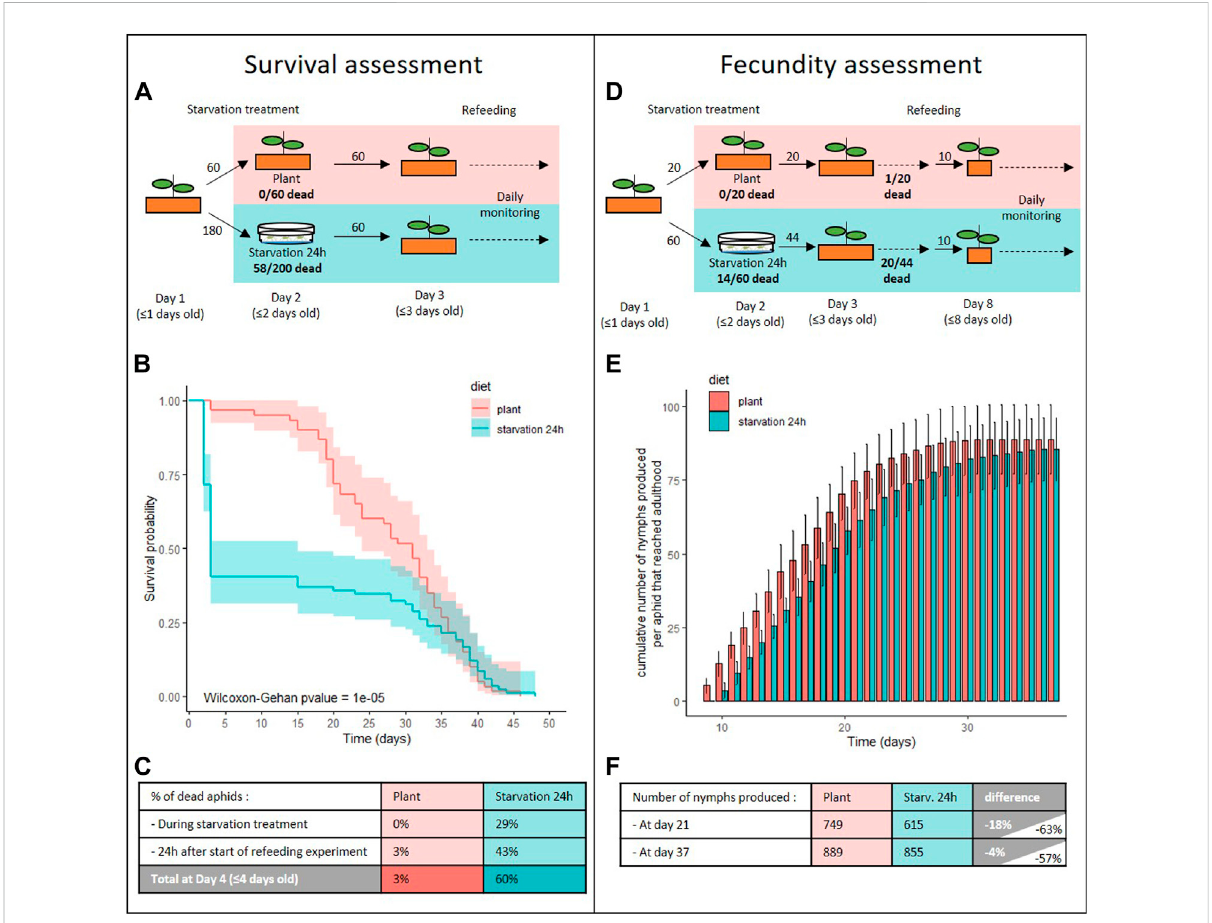
Impactofstarvation stressonaphid survivaland fecundity. (A – C) Survivalanalysisof A.pisum reared onplantfrombirth (plant, red)orthat were starved for 24 h prior to being transferred to plant (starvation 24 h, cyan). (A) Experimental design and number of aphids used for the survival assessment. (B) Survival probabilities of aphids reared in each condition, with their predicted con fi dence intervals. Data were analyzed using the Wilcoxon-Gehan Test. (C) Information on the number of aphids that died during the starvation treatment and in the 24 h following transfer to plants. (D – F) Fecundity analysis of A. pisum reared on plant from birth (plant, red) or that were starved for 24 h prior to being transferred to plant (starvation 24 h, cyan). (D) Experimental design and number of aphids used for the fecundity assessment. (E) Cumulative numbers of progeny